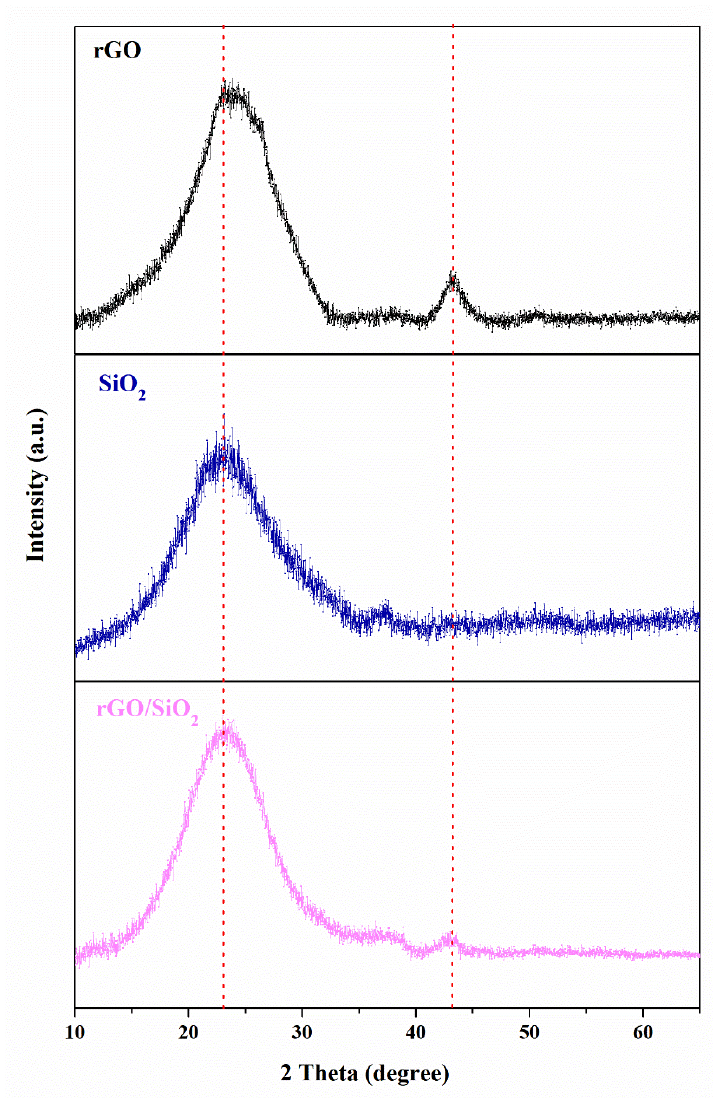
Figure 3. XRD patterns of the rGO, SiO 2 , and rGO / SiO 2 samples.